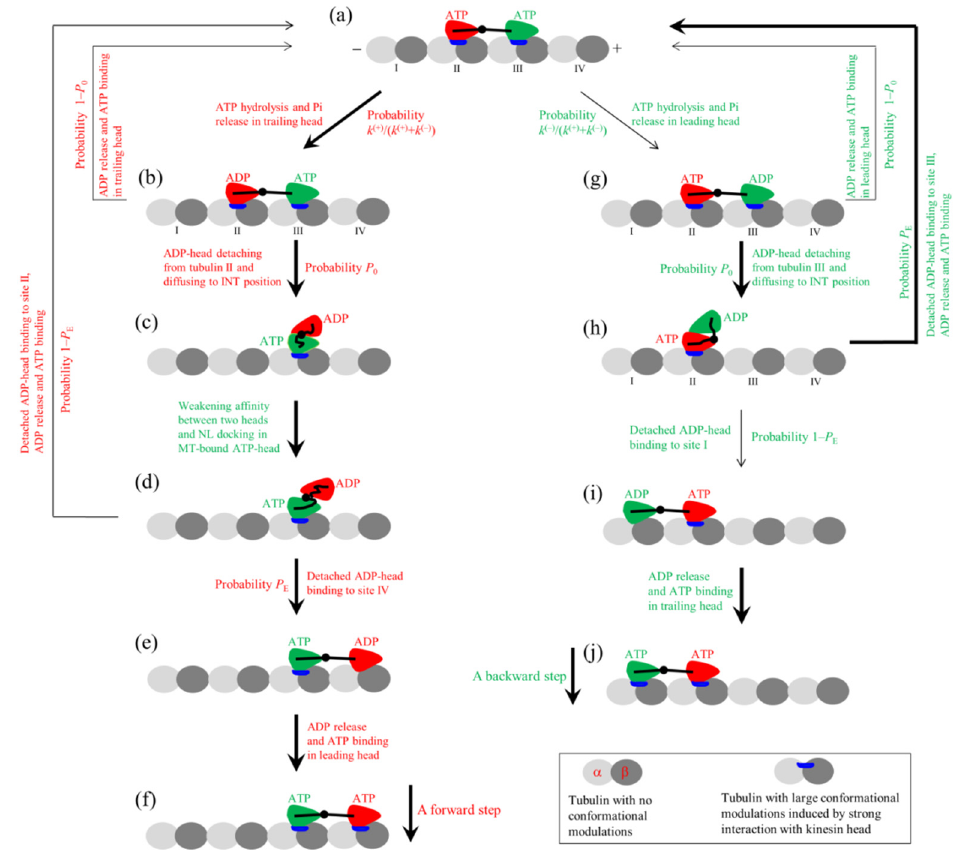
Figure 1. Model for processive stepping of the dimeric kinesin motor. ( a – j ) The chemomechanical coupling pathway at saturating adenosine triphosphate (ATP) concentrations. At saturating ATP, the nucleotide-free state of the kinesin head is so short that it is not needed to be considered. Since in both the ATP and ADP.Pi states, the kinesin head has a similar conformation and has a high affinity to an MT, for simplicity, ATP hydrolysis and Pi release are treated as one step in the ATP transition to adenosine diphosphate (ADP). The thickness of an arrow indicates the relative magnitude of the probability of the transition between two states connected by the arrow for the WT kinesin motor under no